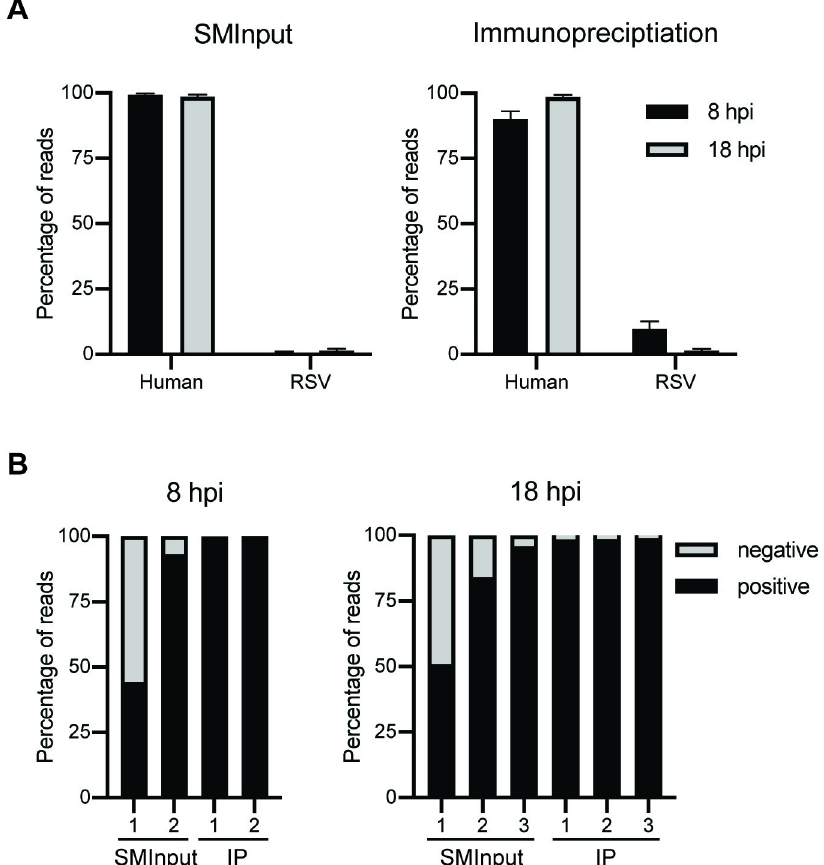
Fig 2. M2-1 binds to cellular and positive sense RSV RNA. (A) Genomic identity of RNA bound by M2-1 at 8 (black) and 18 (grey) hpi. Libraries were aligned to human (hg19) and RSV (NCBI Accession # M74568.1) genomes. Reads that did not map to either of these genomes (for example, poly(A) tails, contaminants from the air and nitrocellulose etc.) were discarded in this analysis, as were ribosomal RNAs and repetitive sequence elements. Analysis was done for SMInput and M2-1 IP samples (left and right panels, respectively). The mean average value of the two replicates at 8 hpi and three replicates at 18 hpi is presented. (B) Percentage of negative (grey) versus positive (black) sense RSV RNA from 8 hpi and 18 hpi (left and right panels, respectively). Each individual replicate is represented.